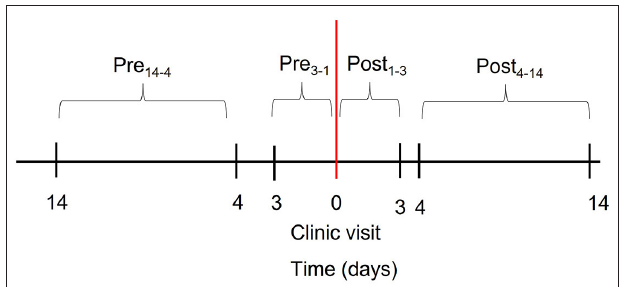
FIGURE 1 | Study design. Study periods within the 28 days evenly bracketing the clinic visit (red line) are depicted by black brackets.